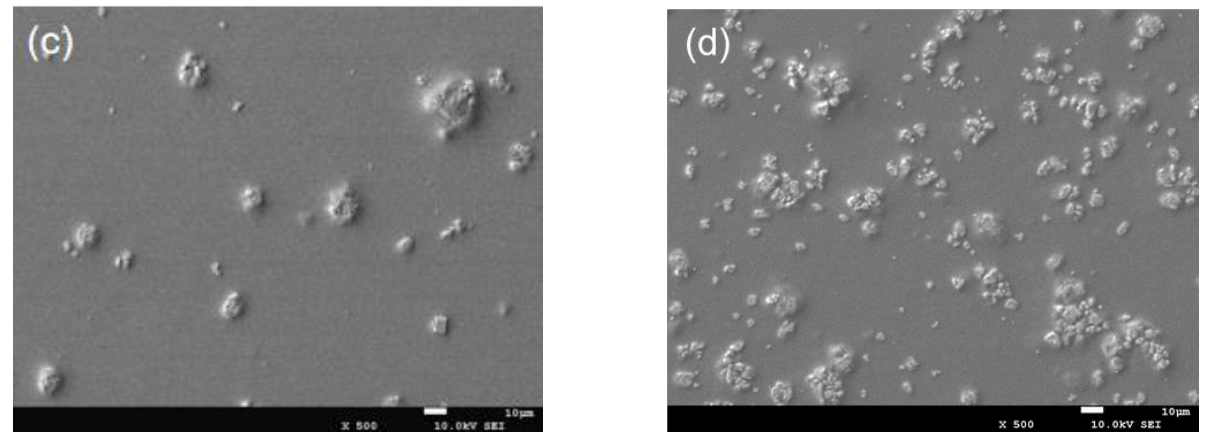
Figure 1. SEM image of pure chitosan film and different content of nano-TiO 2 composite film (ck: pure chitosan coating film; ( a – d ): the chitosan composite coating film containing 0.1 g, 0.3 g and 0.5 g of modified nano-TiO 2 respectively).